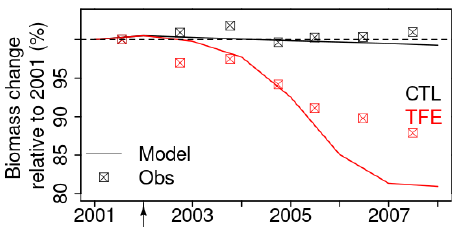
Figure 9. Tree biomass change simulated by model after mortal- ity being triggered. The squares in the plot denote the observation. Biomass change relative to 2001 is calculated by dividing biomass during 2002–2008 by biomass in 2001.